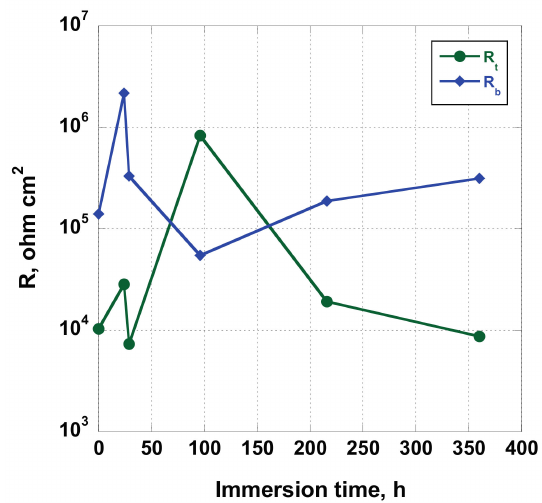
Figure 14. Variation of R t and R b as a function of time of immersion in Hank’s solution displayed by the NT sample.